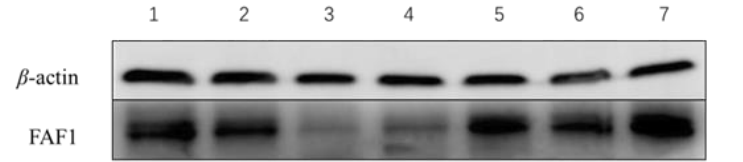
Figure 2. β -actin and FAF1 protein in testes of different ages.